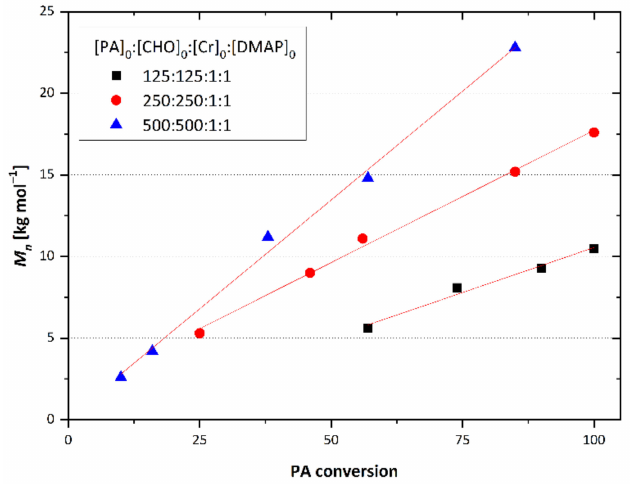
Figure 4. Relationships between M n and PA conversion for 3a /DMAP, depending on the initial